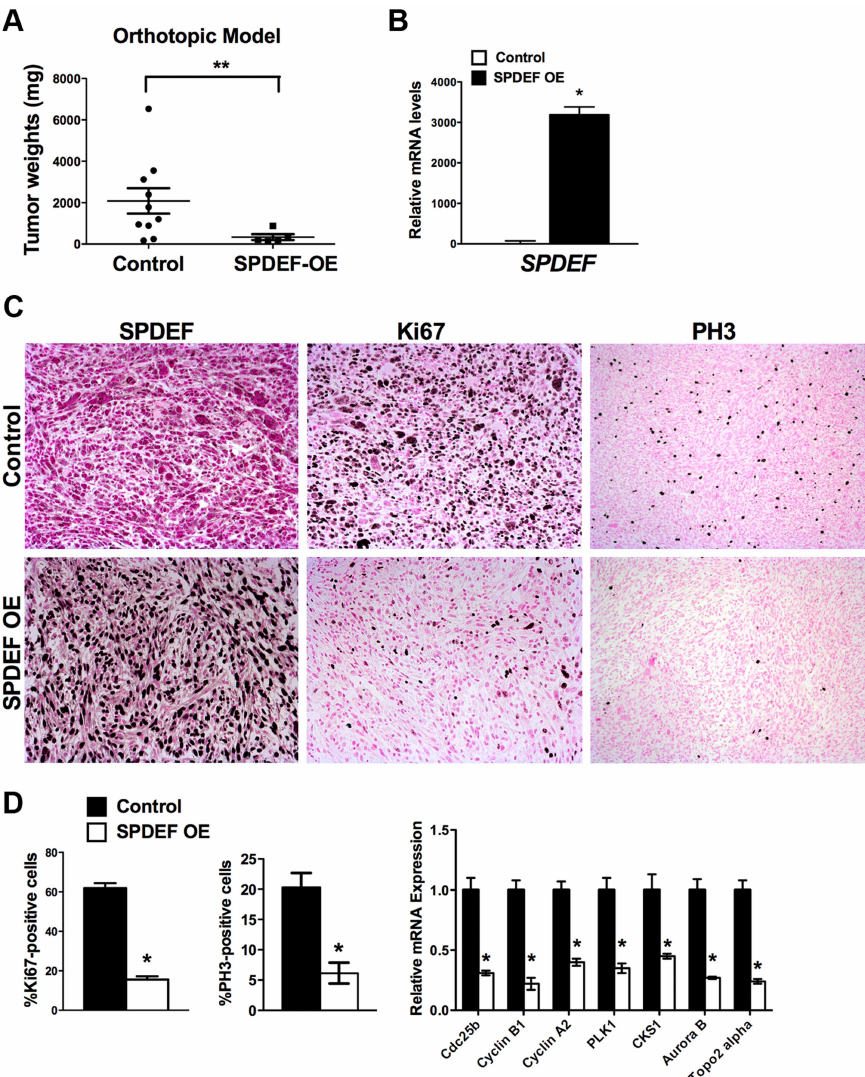
Figure 3. Expression of SPDEF in prostate adenocarcinoma cells decreased prostate carcinogenesis in orthotopic model. Mouse prostates were harvested 5 weeks after inoculation of control TRAMP C2 adenocarcinoma cells or TRAMP C2 cells with stable expression of SPDEF (SPDEF OE). A . SPDEF decreased the growth of prostate tumors in orthotopic model. Mean weights of prostate glands ( 6 SD) are shown (n=10 for control TRAMP C2 cells, n=5 for SPDEF OE cells). B . mRNA levels of SPDEF in tumors are shown by qRT-PCR. C . SPDEF decreased cellular proliferation as demonstrated by reduced numbers of Ki-67-positive and PH3-positive cells. Magnification is 6 100. D . Percentage of Ki-67-positive and PH3- positive cells were counted in five random microscope fields (n=3 mice per group, left panels). Decreased mRNA levels of proliferation-specific genes in SPDEF OE prostates were found by qRT-PCR (right panel). Data represent means 6 SD of three independent determinations using prostate tissue from n=5–10 mice in each group. A p value , 0.01 is shown with (**) and p value , 0.05 is shown with